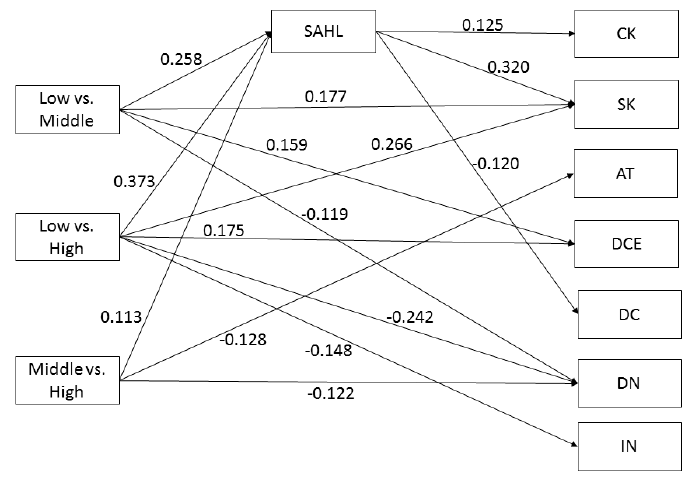
Figure 2. Comprehension (SAHL) as mediator. Note: CK = CRC knowledge; SK = screening knowledge; AT = attitude; DCE = decisional certainty; DC = decisional conflict; DN = descriptive norm. Non-significant paths are not shown.